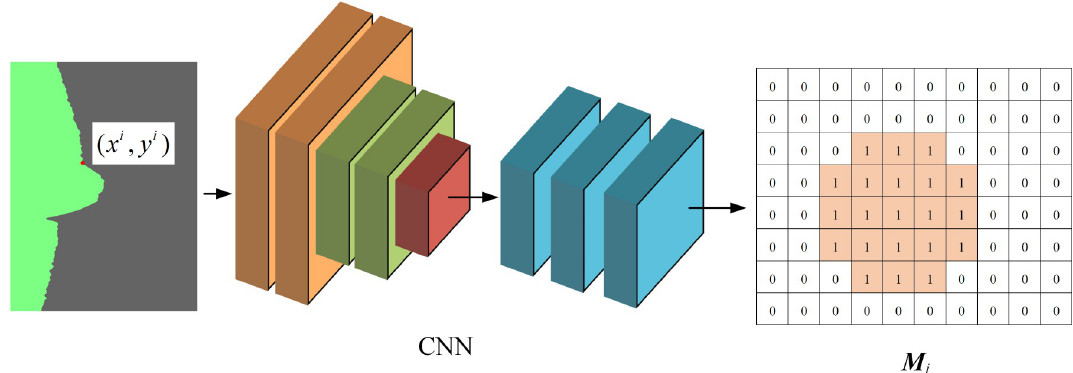
Fig 7. Theoretical output results of EDE-net branch